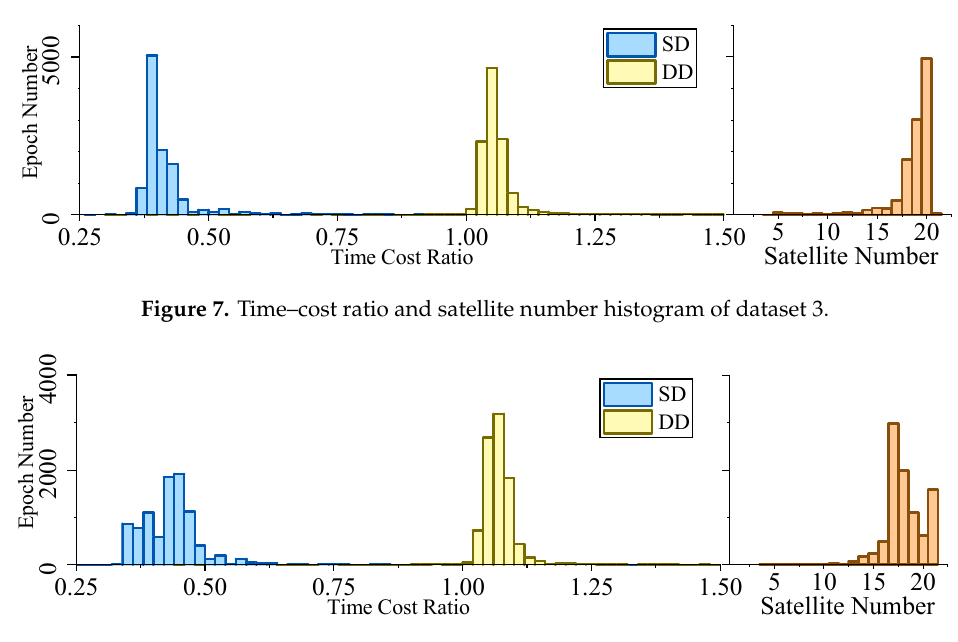
Figure 8. Time–cost ratio and satellite number histogram of dataset 4.